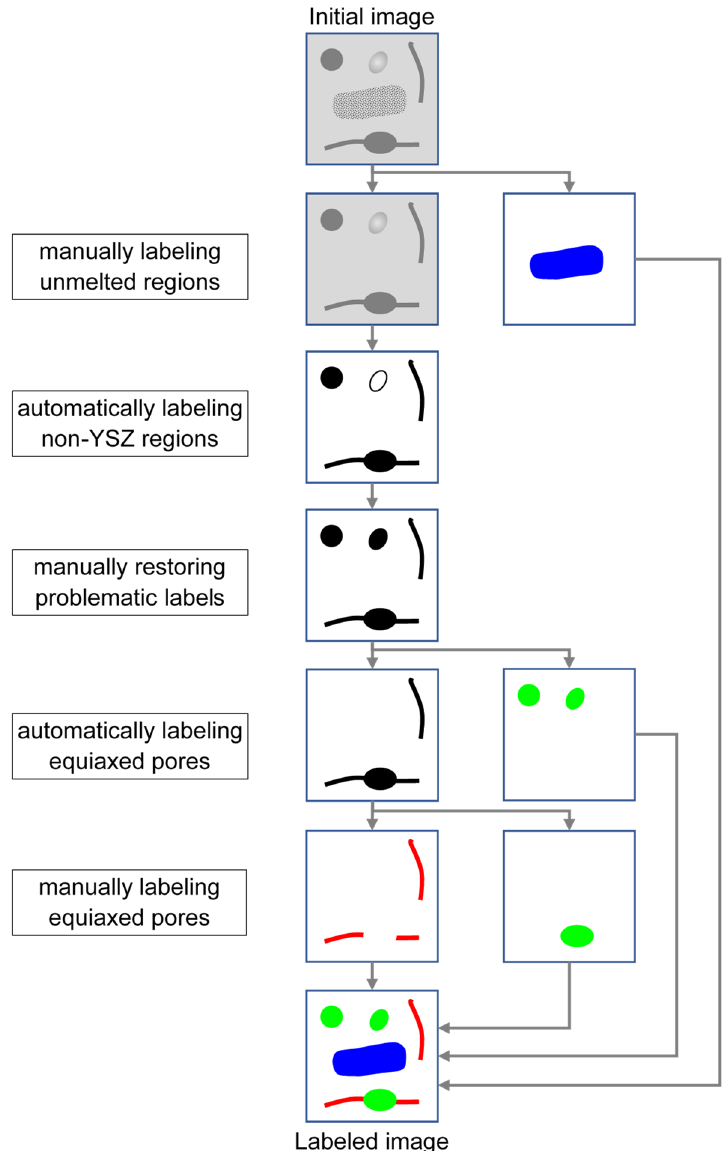
Figure 4. Schematic showing the labeling process.